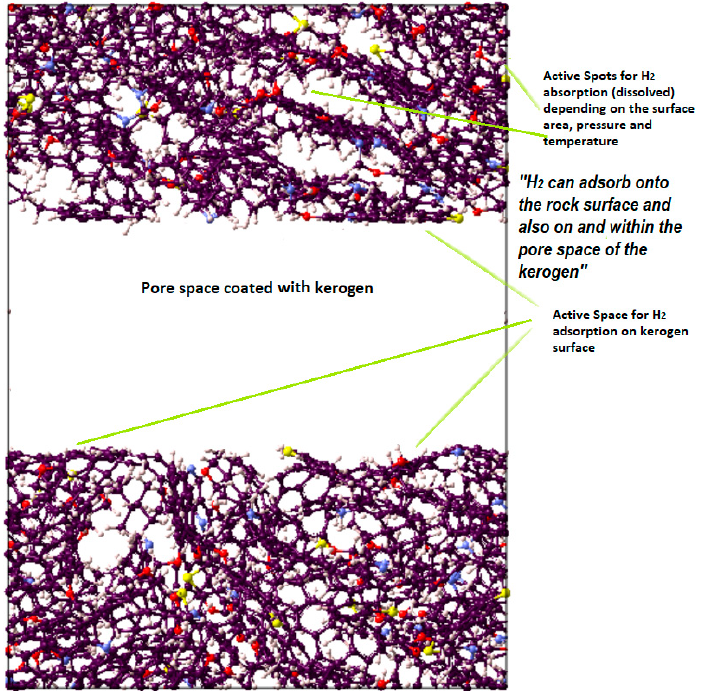
Figure 8. Visual representation of the molecular model for active spots available in II-D (overmature-type kerogen) H 2 absorption within the structure and adsorption on the surfaces.